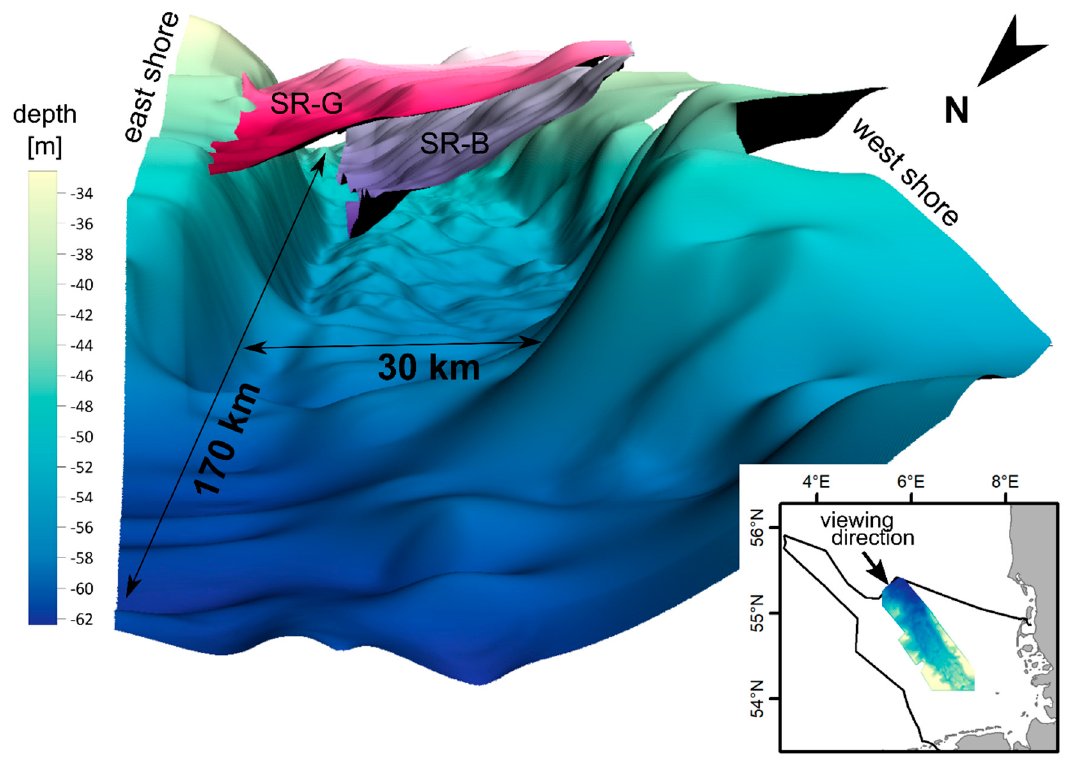
Figure 6. A 3-D model of the Paleo Elbe Valley basin and the upper boundary of seismic unit SU-2 (SR-B) and seismic unit SU-3 (SR-G).